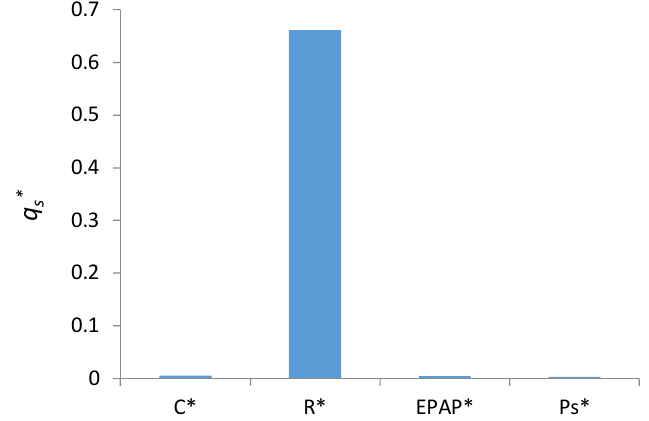
Figure 15. Standard deviation of dimensionless suction duration ( T sd * ).